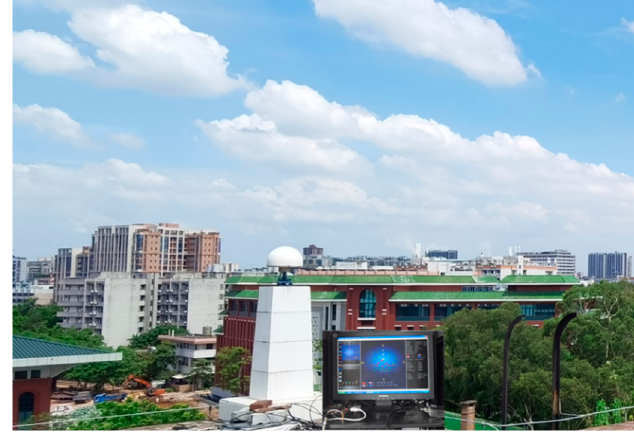
Figure 21. Base station for DGNSS experiment on SYSU campus.